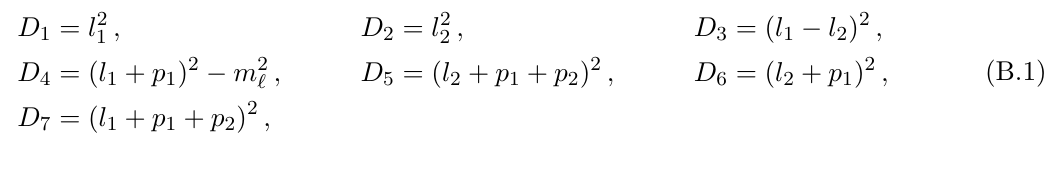
Unlike the 7 topologies in eqs. (A.2) and (A.5), [1 , 1 , 0 , 1 , 1 , 1 , 1] in eq. (A.8) is a three-point non-planar topology, which is represented schematically by the non-planar graph in figure 3. The two-loop scalar integrals induced by the non-planar Feynman diagrams via tensor reduction belong to S 3